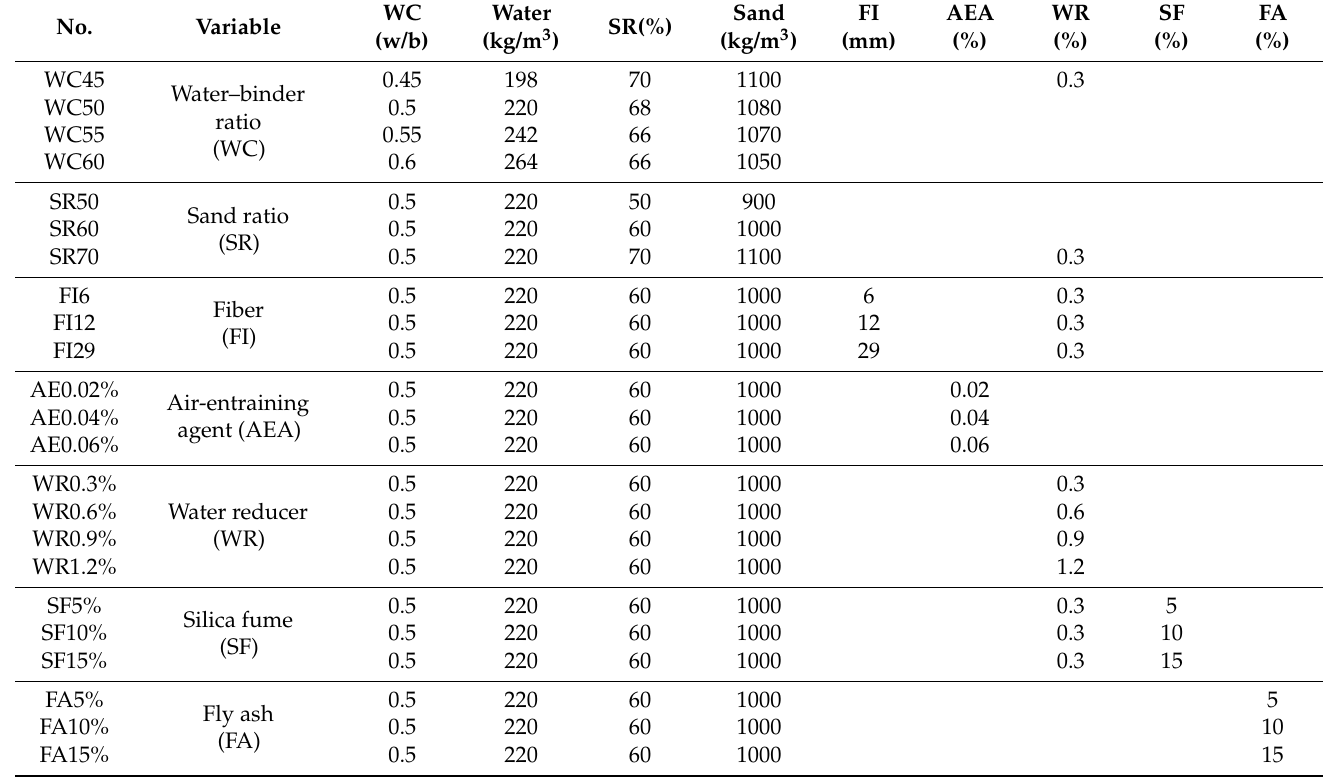
Table 1. Mixture proportions of fresh wet shotcrete.